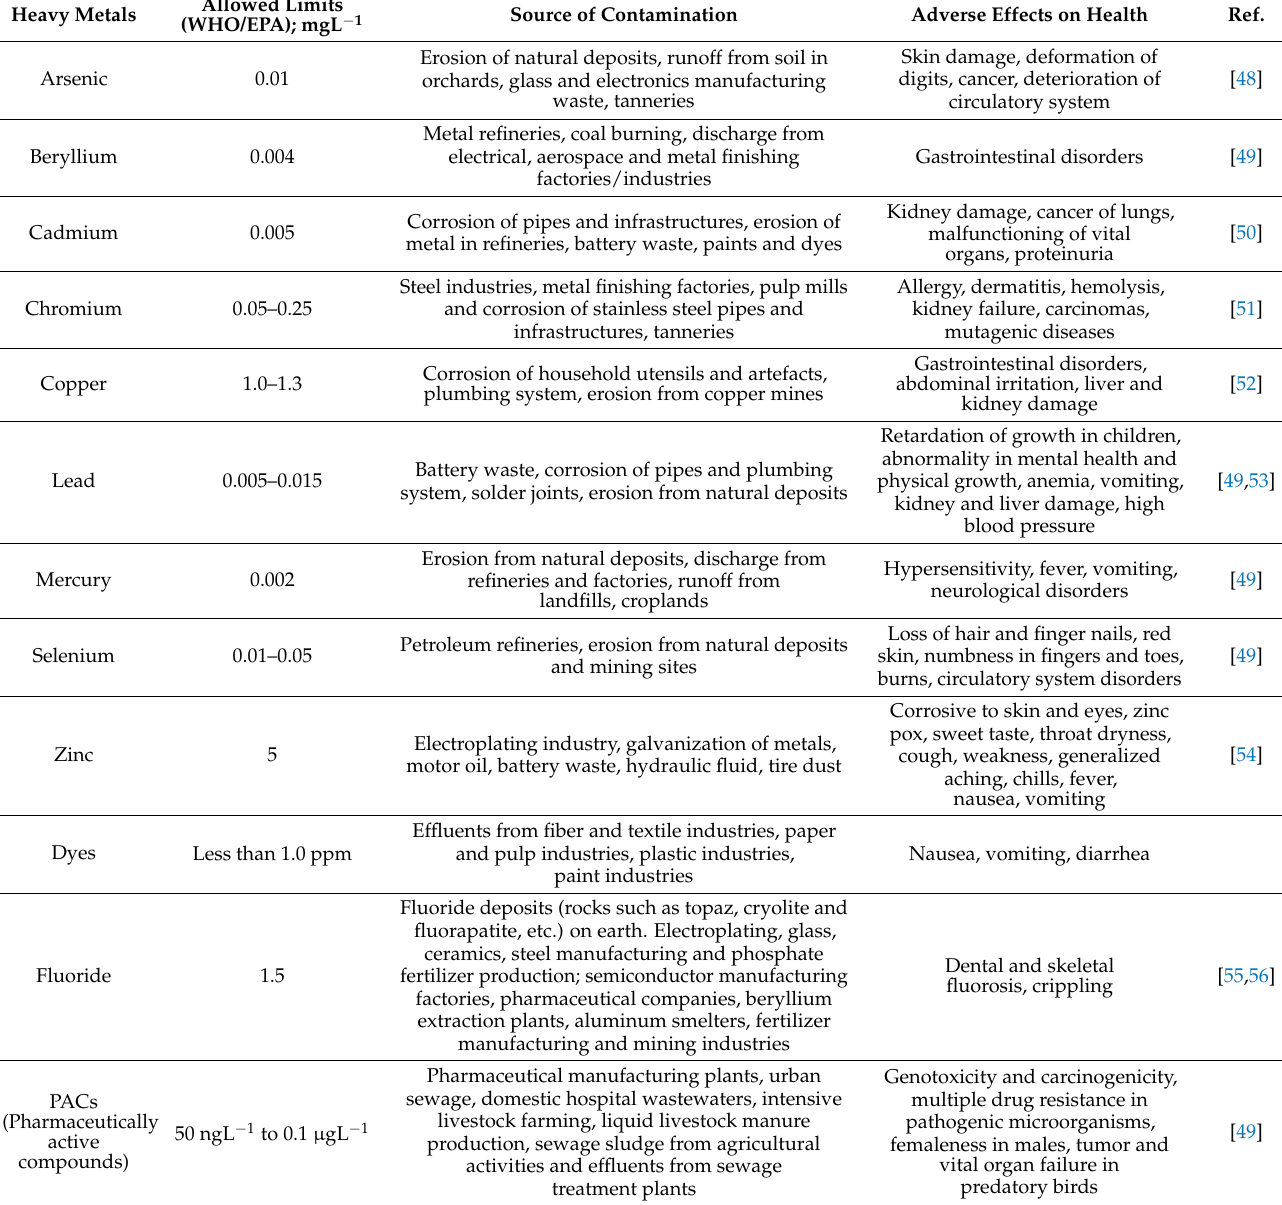
Table 1. The permissible limits and the hazardous effects of heavy metals, dyes and other contaminants on human health. Heavy